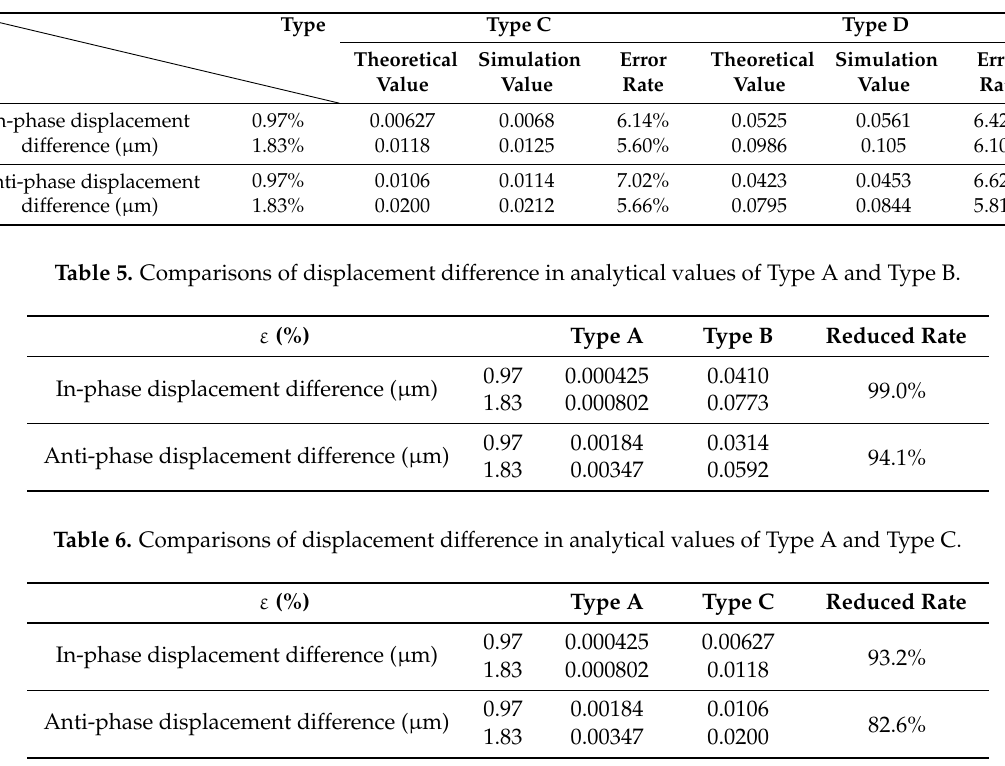
Table 4. Comparisons with theoretical and numerical values of Type C and Type D.